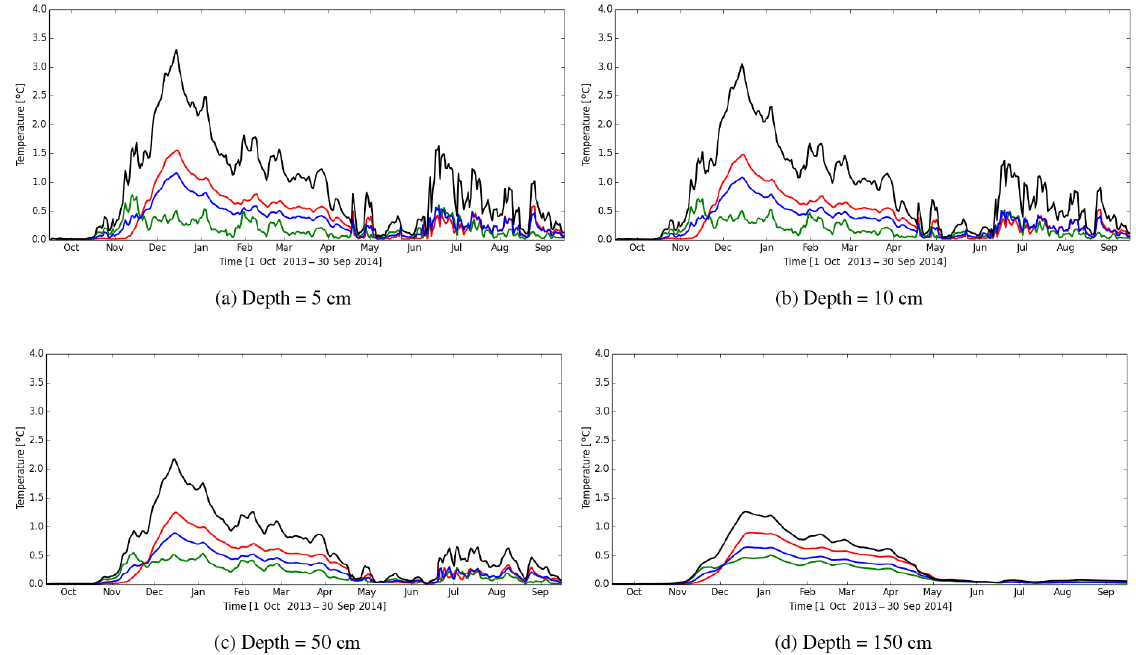
Figure 11. Spatiotemporal variability (standard deviation) in simulated soil temperature at Site A at depths 5, 10, 50 and 150cm. High vari- ability in soil temperatures was observed across the region during the year, especially cold winters with centers showing highest variability. Red, green and blue lines represent center, rim and trough respectively, and the black line represents the standard deviation across Site A.